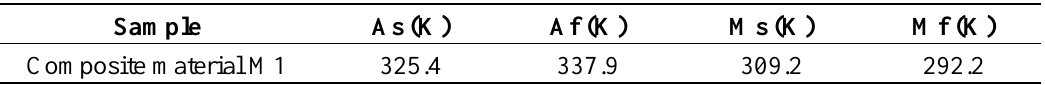
Table 2. Transformation temperatures of the composite material obtained by